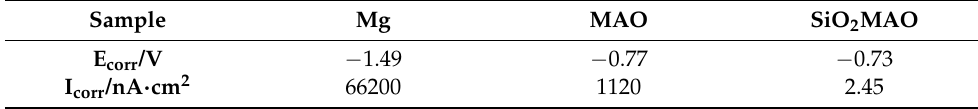
Figure 6. The equivalent circuit model of the ( a ) Mg alloy sample, ( b ) SiO 2 /MAO and MAO coating samples. Table 5. Potentiodynamic polarization curve fitting results.